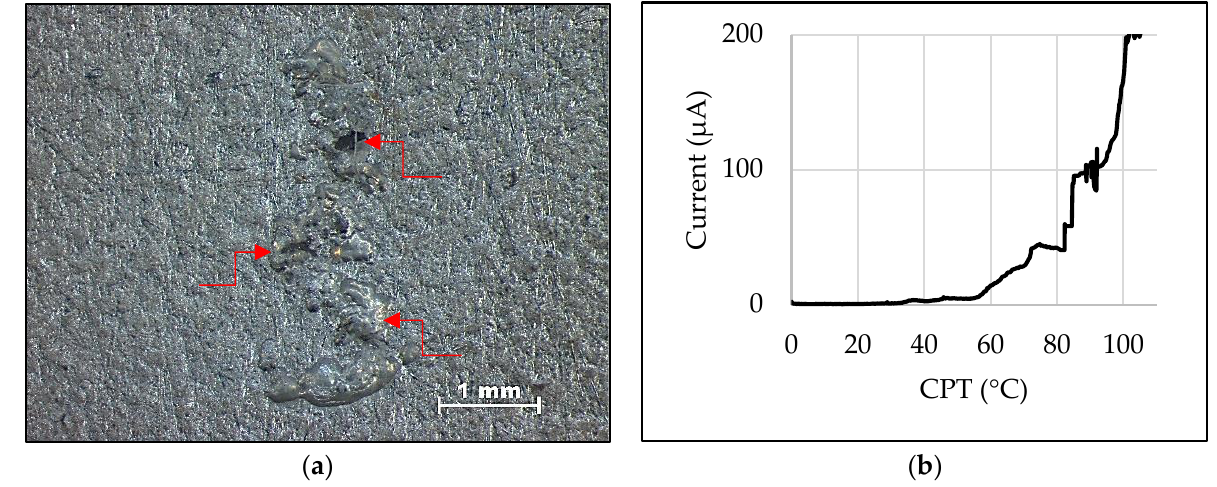
Figure 5. ( a ) Base metal surface after the CPT test. Arrows indicate pitting corrosion. ( b ) CPT test graph of the base metal, showing the current reaching 100 μA at a temperature of 92 °C.